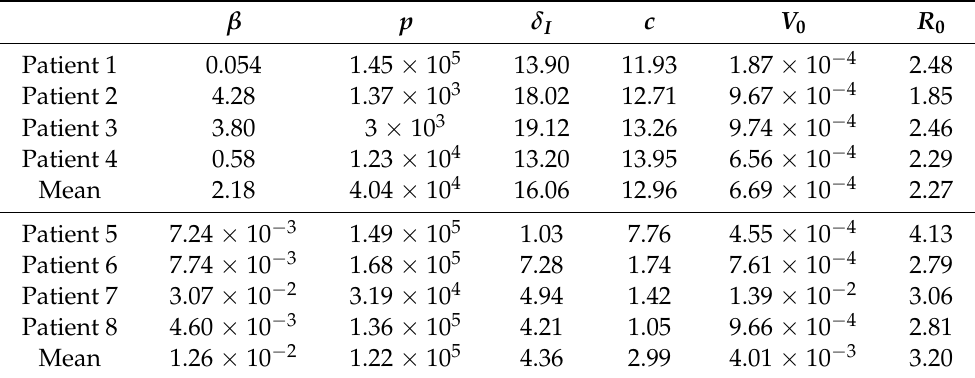
Figure 4. Dynamic changes in eight patients’ viral loads: patients 1, 2, 3, and 4 are mild disease patients; patients 5, 6, 7, and 8 are severe disease patients. The peak viral load of mild patients (11.24, 8.97, 9.39, 10.11) is greater than that of severe patients (12.22, 12.16, 11.64, 12.39), and the viral load of mild patients peaks earlier than that of severe patients. Table 3. Some parameter values in Model 1 and Model